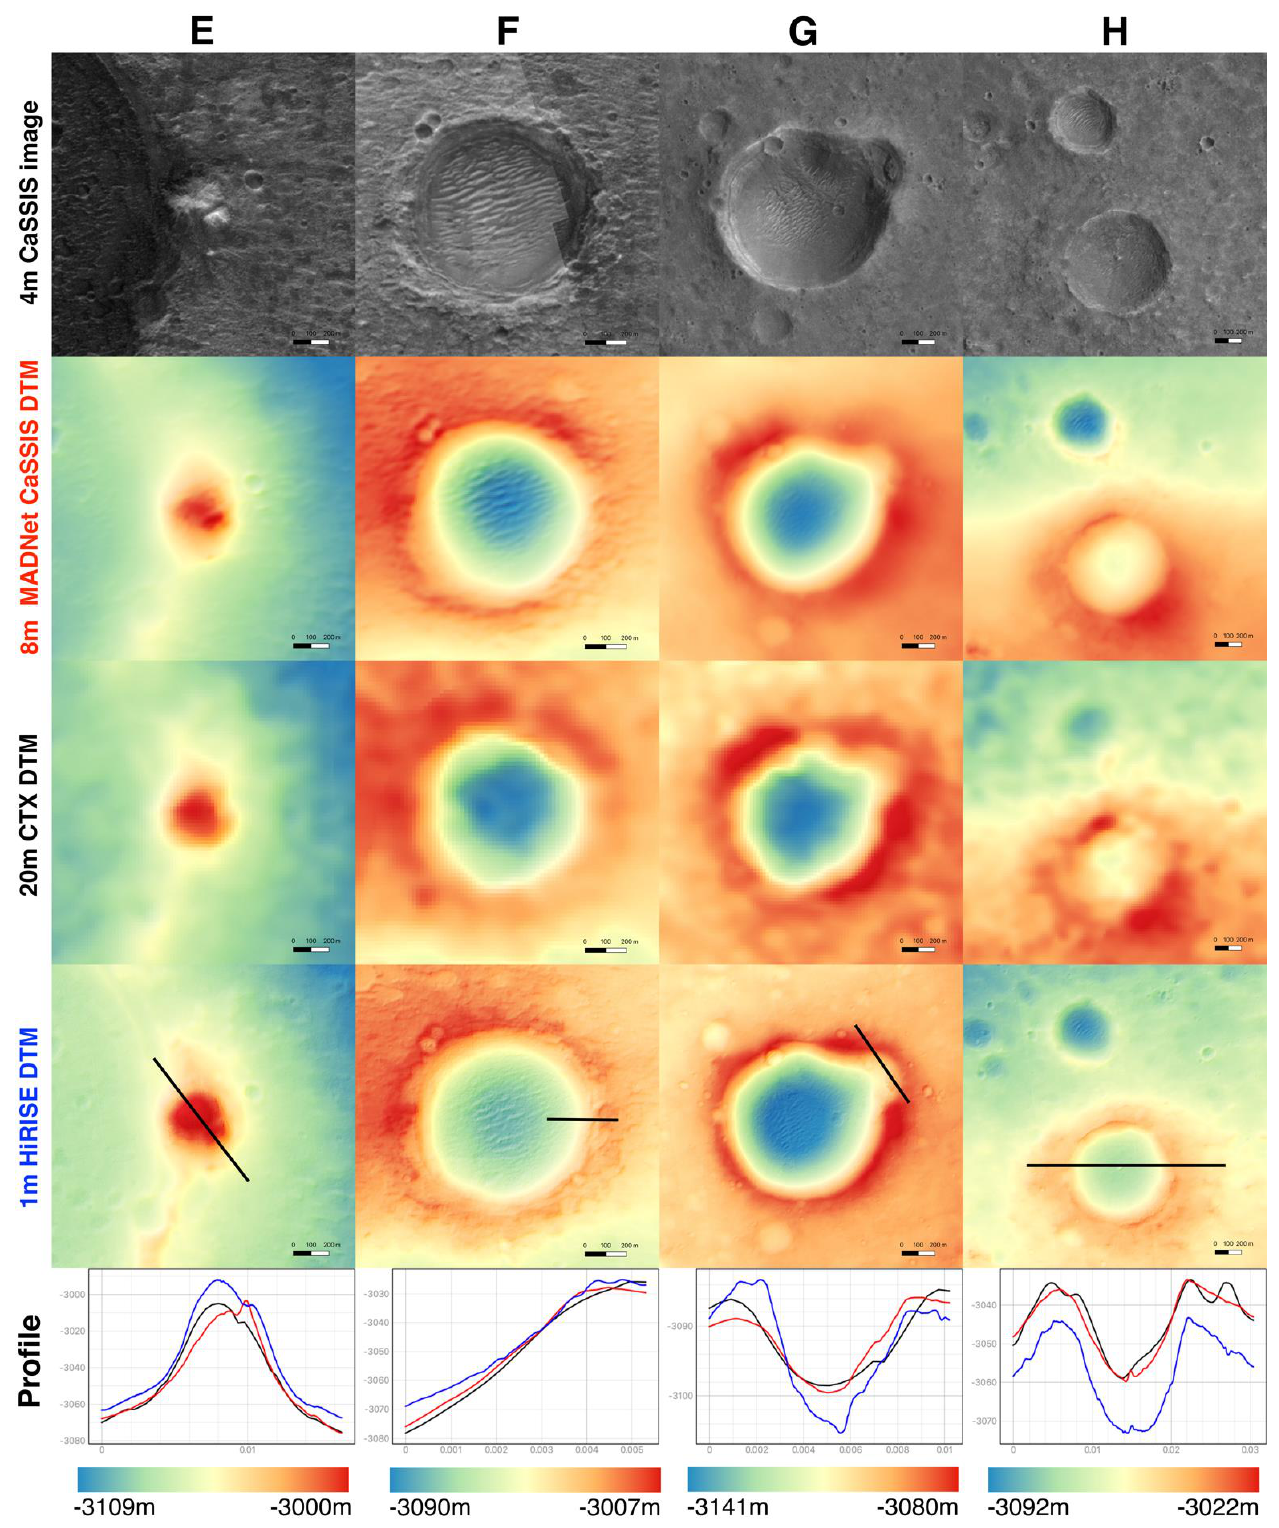
Figure 7. Zoom-in views of the 4 m/pixel CaSSIS image, 8 m/pixel MADNet CaSSIS DTM, 20 m/pixel CTX DTM, 1 m/pixel HiRISE DTM, and measured profiles (location shown on the HiRISE DTMs; black: CTX, red: CaSSIS, blue: HiRISE), for area ( E – H ) (location shown in Figure 5). All DTMs are colour hillshaded. To look into details—please refer to the full-resolution figures provided in Supplementary Materials.